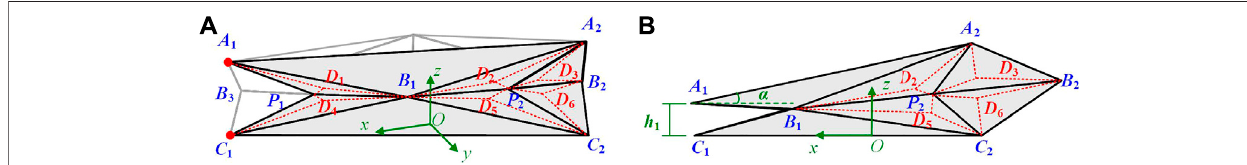
FIGURE 5 | Virtual creases of a single-layer Yoshimura-ori structure under bending motion. (A) Panels A1B1P1, A2B1P2, A2B2P2, B1C1P1, B1C2P2, and B2C2P2 are respectively divided into two rigid triangular panels by a virtual crease. (B) Side view of the structure, where the variables α and h1 are